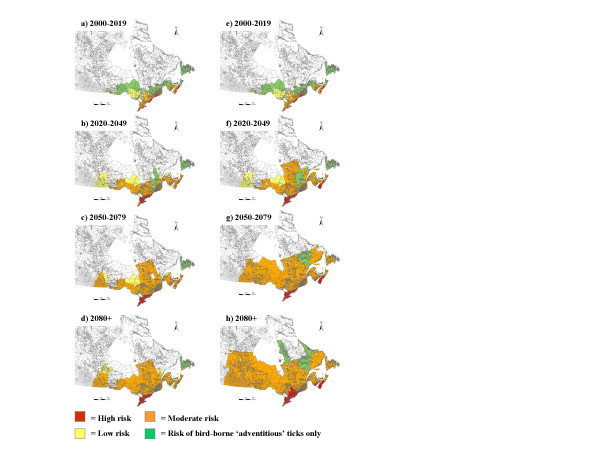
Risk maps for the occurrence of the Lyme disease vector Ixodes scapularis. Expansion of I. scapularis-affected CSDs in Canada from the present (using 1971–2000 temperature normals) to the 2080s (using the temperature conditions predicted by the CGCM2 climate model under emissions scenario A2). In Figs a to d, the 'slow' scenario, the model assumes that by the end of each time period, only risk CSDs with an algorithm value in the top 10% will contain an I. scapularis population. In Figs e to h, the 'fast' scenario, the model assumes that by the end of each time period, all CSDs within the 'moderate' risk zone for I. scapularis establishment (risk CSDs) contain an I. scapularis population. For both scenarios, the time steps are 2000 to 2019, 2020 to 2049, 2050 to 2079 and 2080 to 2109. The 'high' risk regions for I. scapularis population establishment are indicated in red, the 'moderate' risk regions are in orange, the 'low' risk regions are in yellow, regions with no risk of established populations but some risk from bird-borne 'adventitious' ticks are in green, and regions with no predicted risk of either are colourless.